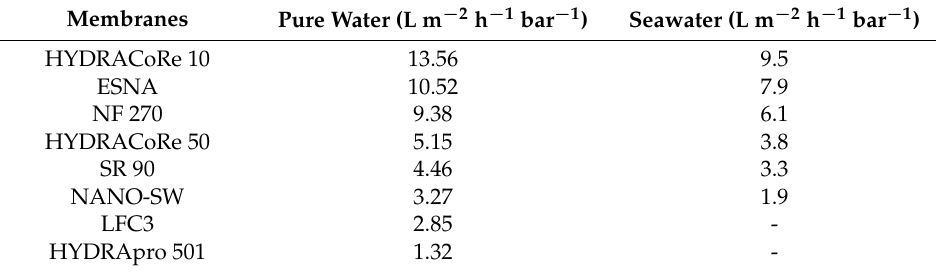
Table 3. The permeability of membranes with different feed solutions.